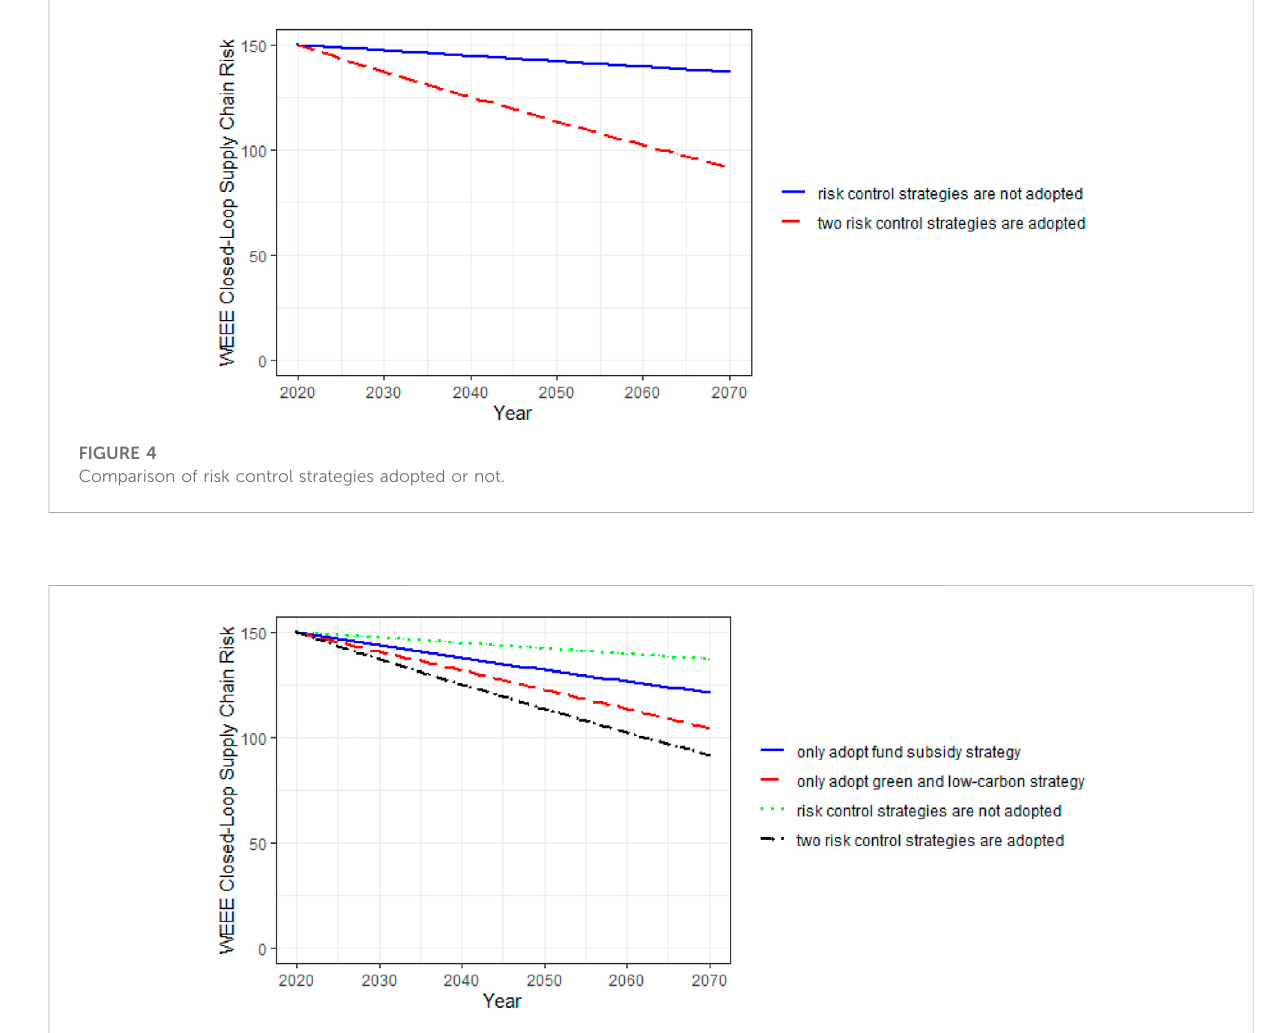
FIGURE 5 Comparison diagram of the risk control strategy